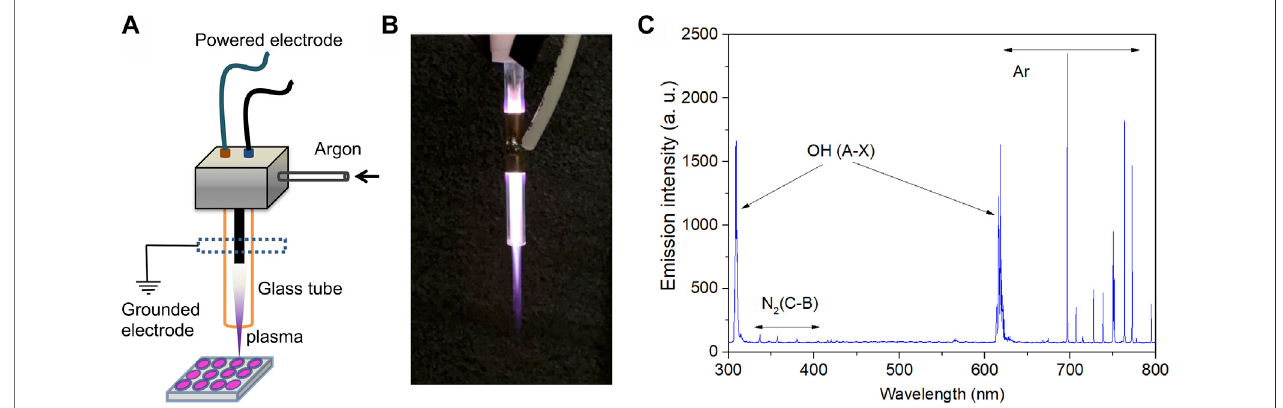
FIGURE1| Characteristicsofplasmadeviceandtheemissionpro fi les. (A) Schematicdiagramand (B) dischargephotographoftheargonplasmajet. (C) Emission spectra of the CAP jet used in the present study.